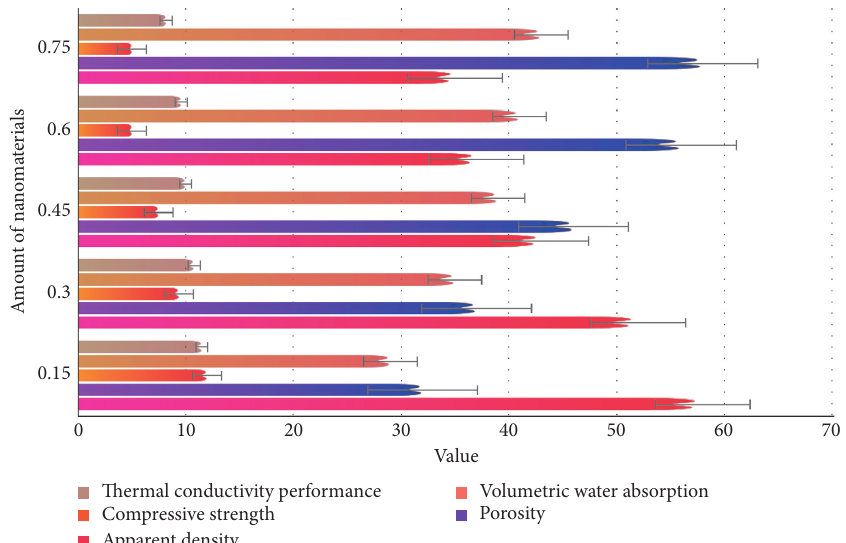
Figure 4: Result analysis diagram of AES parameters of